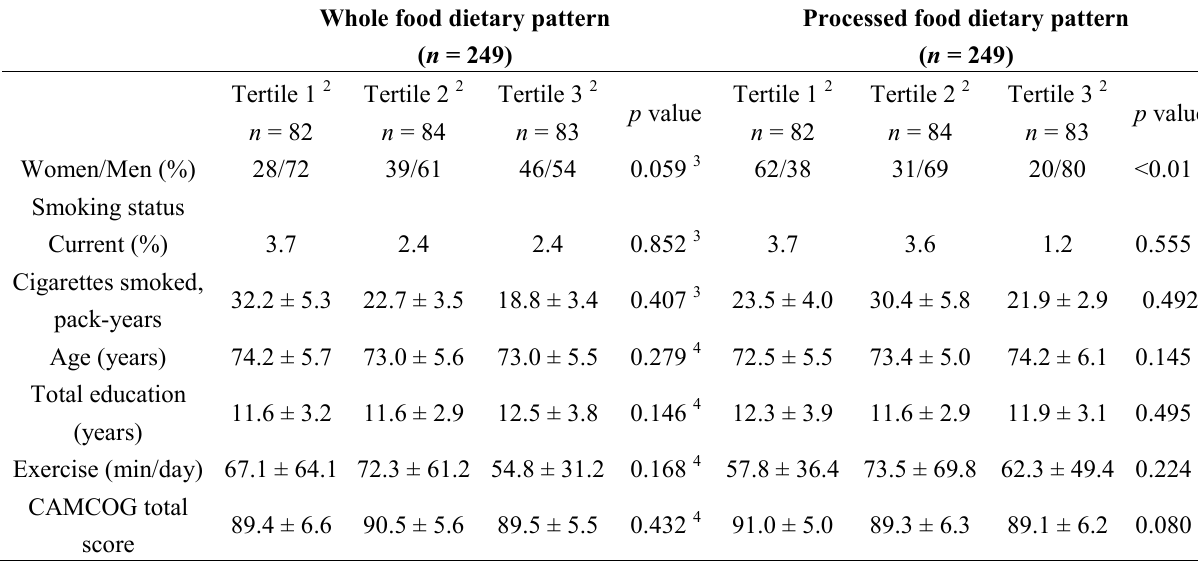
Table 2. Characteristics of study participants according to tertiles of dietary pattern score 1 . Whole food dietary